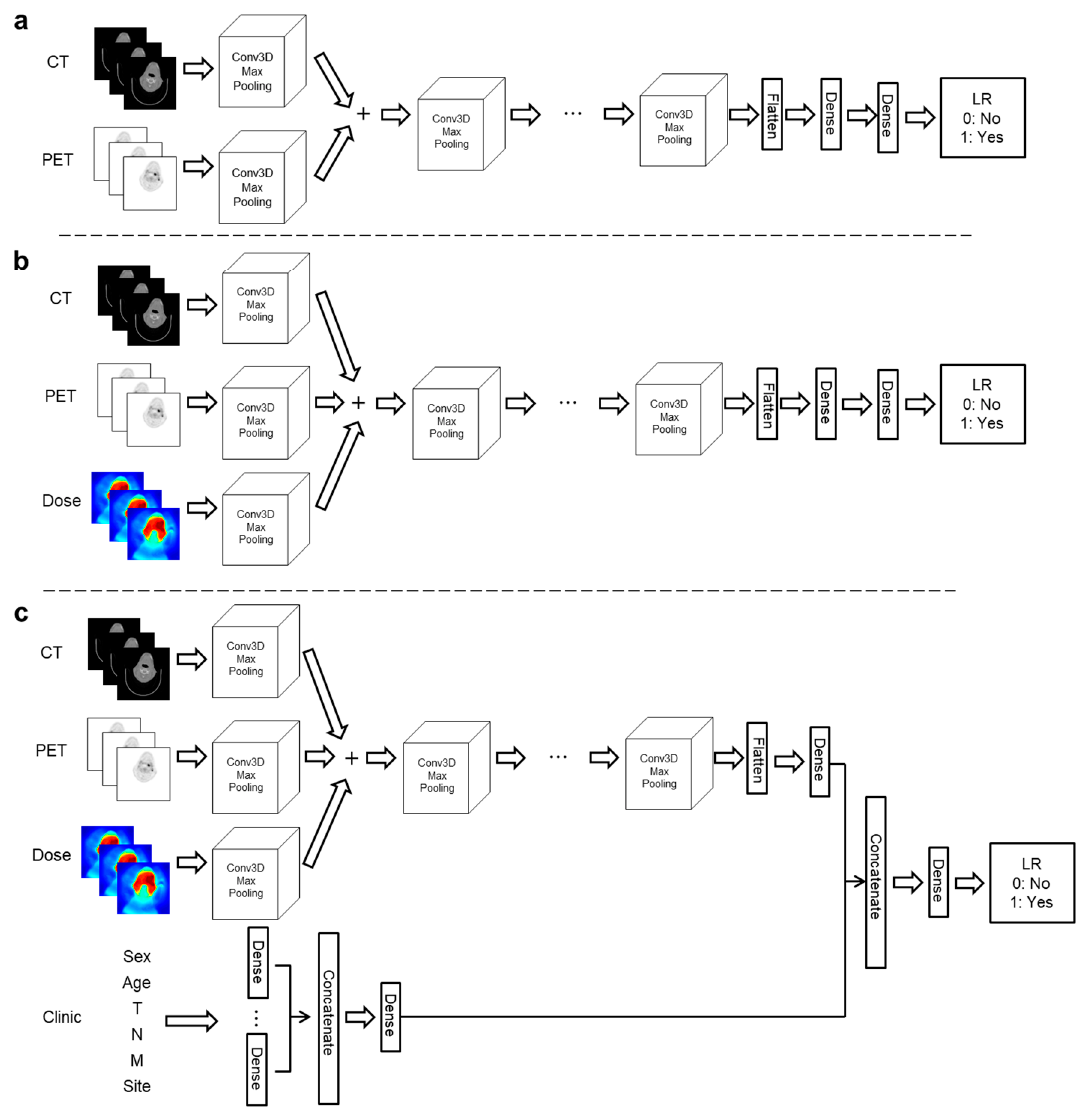
Figure 1. Deep learning model for predicting locoregional recurrence (LR): ( a ) DL model for CP (CT+PET) model. ( b ) CPD (CT+PET+Dose) model. ( c ) CPD-C (CT+PET+Dose+clinical factors) model. Architectures of DL models in detail can be found in Supporting Information.